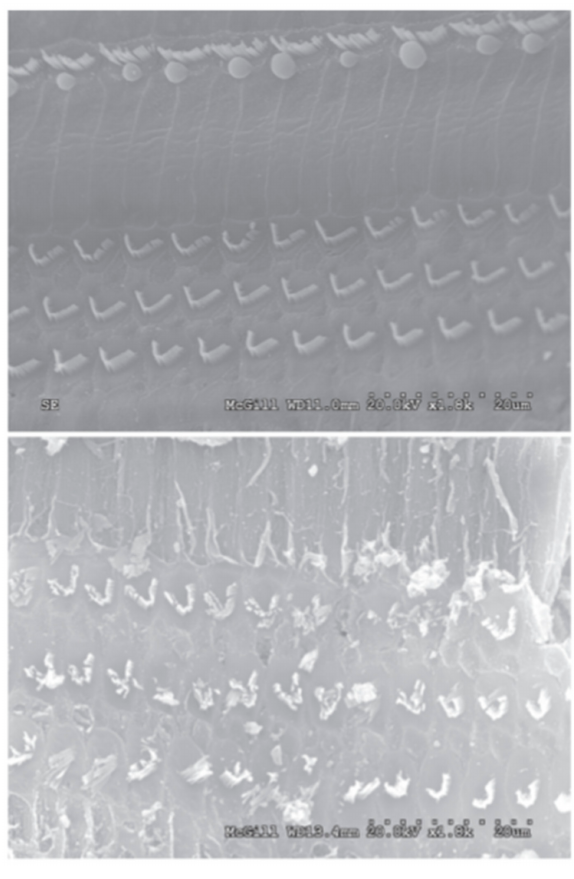
Figure 2. Undiluted honey damages cilia. ( Top ) SEM of saline-exposed chinchilla cochlea, in which normal inner and outer hair cells are observed. ( Bottom ) SEM of honey-exposed chinchilla cochlea in which the inner and outer hair cells have been damaged. Reproduced with permission from Aron et al., Otolaryngology—Head & Neck Surgery ; published by BMC,